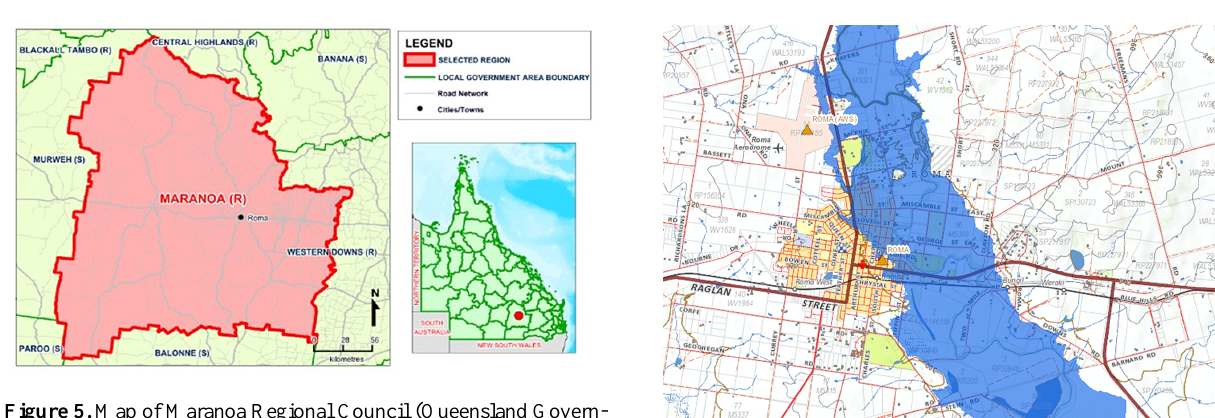
Figure 5. Map of Maranoa Regional Council (Queensland Govern- ment, 2011b).